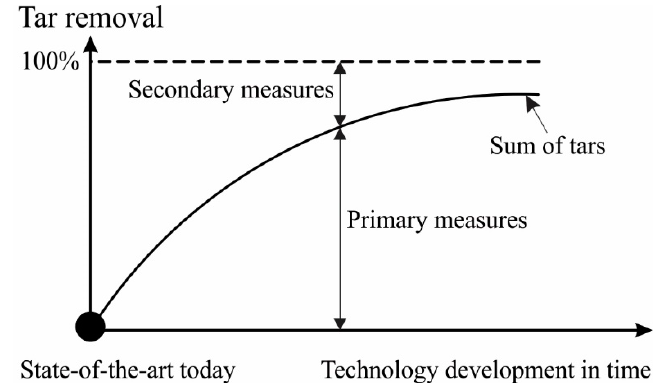
Figure 1. Illustration of the need for primary and secondary measures [2].